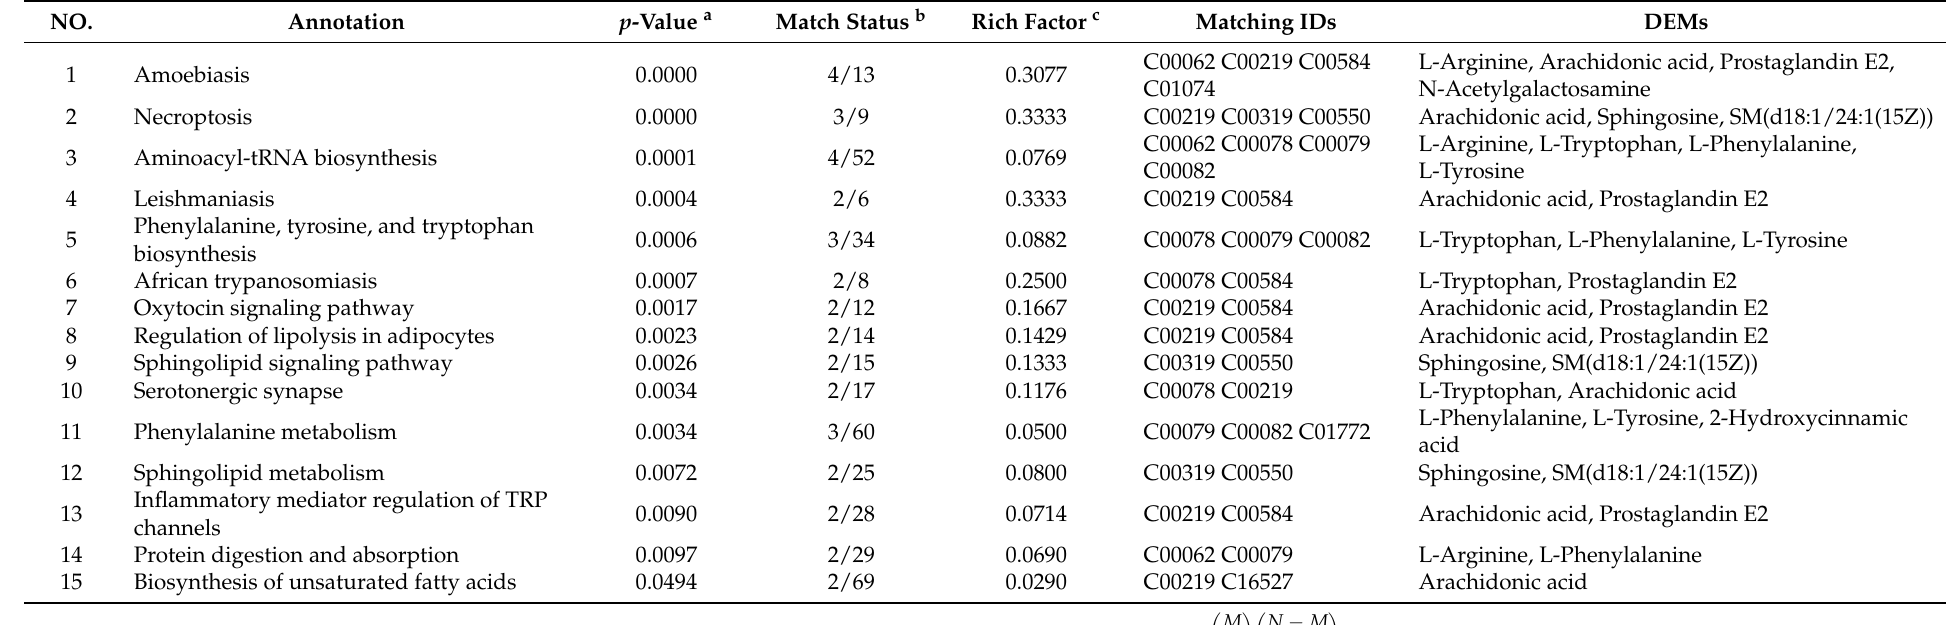
Table 3. The list of the potential pathways involved in cartilage